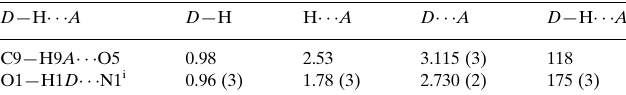
Hydrogen-bond geometry (A˚ , (cid:2)